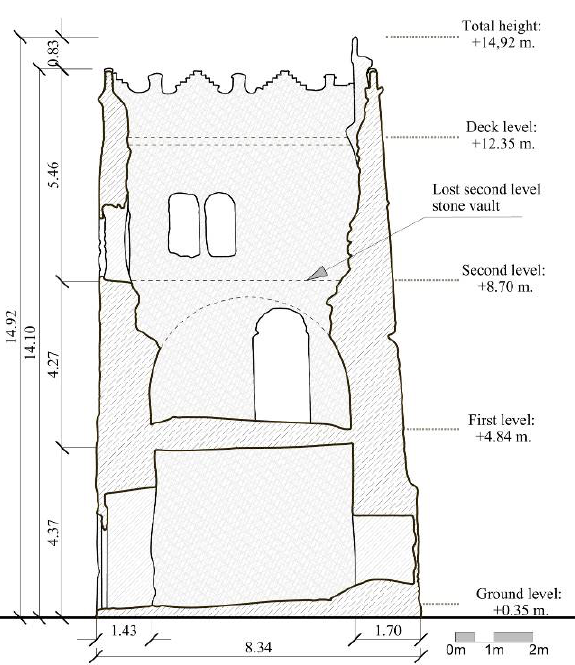
Figure 3. Cross section; north-south direction of the Negro Tower. Current state. Own production.